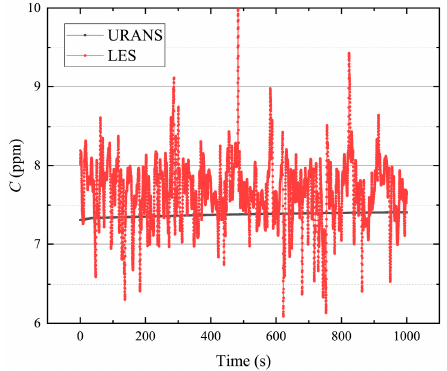
Figure 19. Time history curves of pollutant concentration at Point 3.